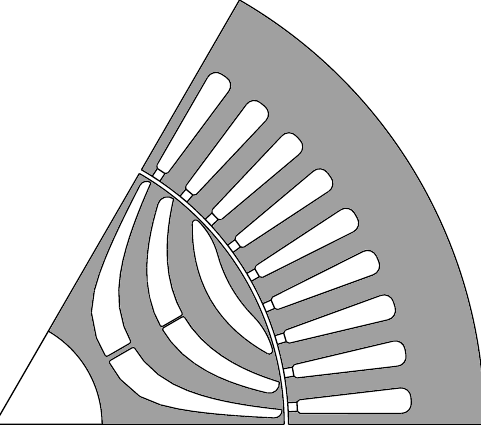
Figure 1. One-pole cross-section of a 54s-6p